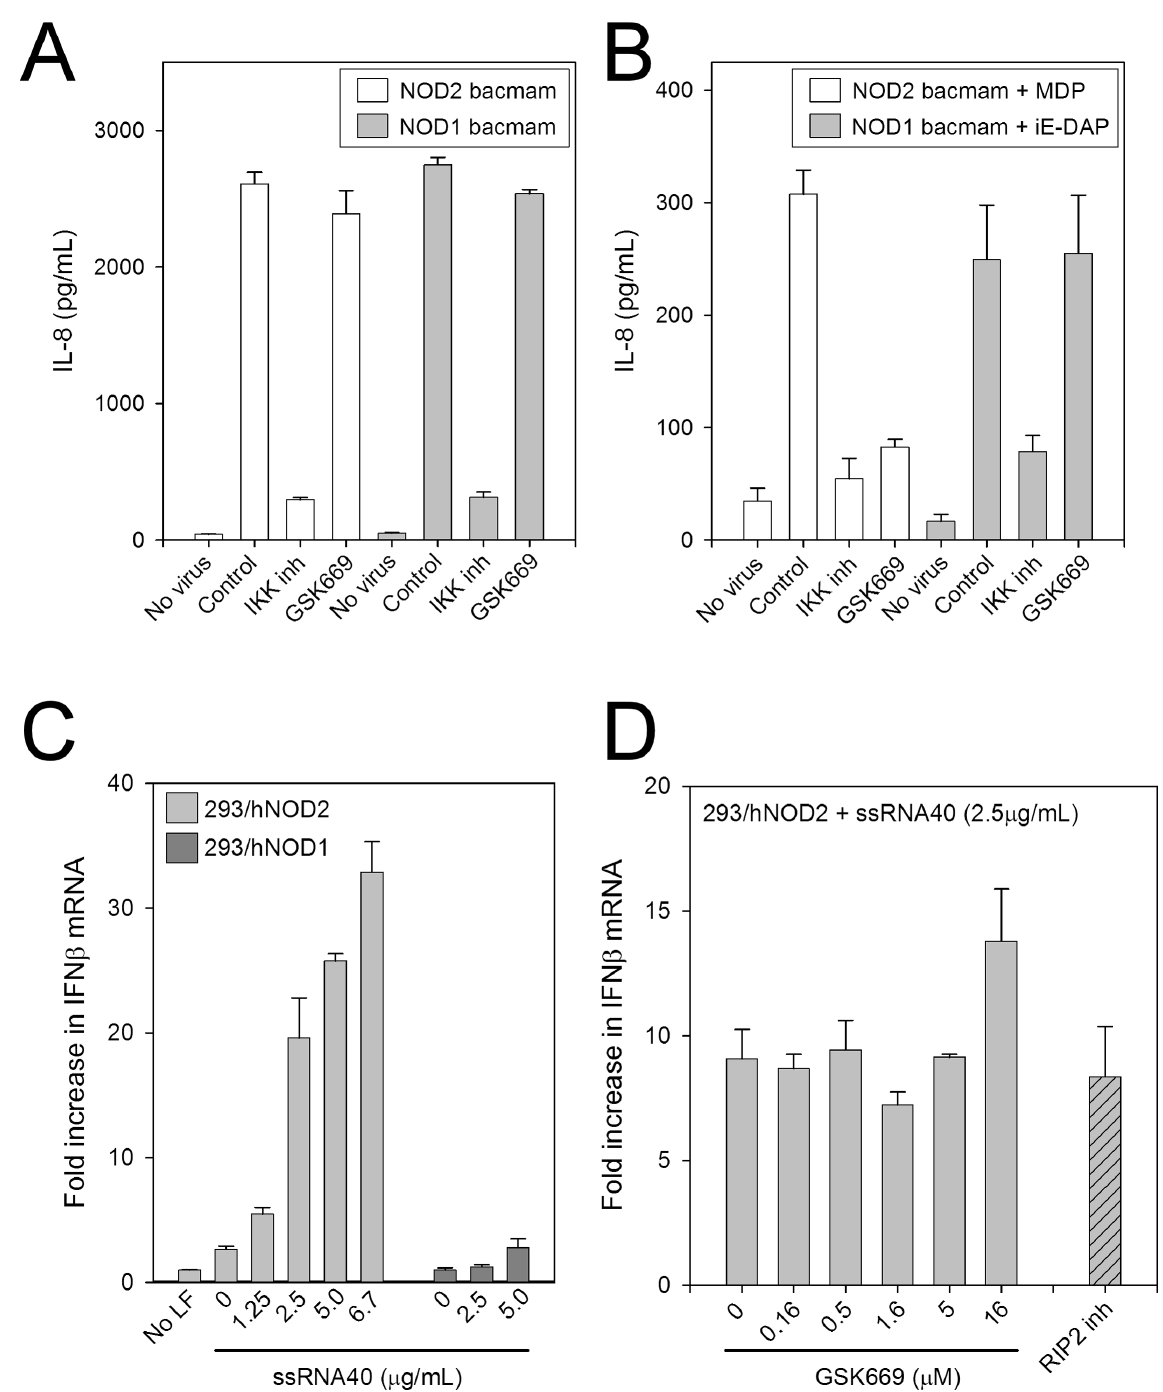
Figure 6. The activity of GSK669 is specific for inhibition of MDP-stimulated NOD2 responses. (A and B) Over-expression of NOD2 by viral transduction in HEK293T cells induces secretion of IL-8. Cells were infected (MOI=50) with NOD1 or NOD2 bacmam virus alone for either 24 hours (A) or for 6 hours followed by removal of virus and stimulation with iE-DAP (300 ng/mL) or MDP (30 ng/mL) for an additional 24 hours (B). GSK669 (5 m M) failed to block IL-8 secretion induced by NOD1/2 virus alone but selectively blocked the MDP response in NOD2 transduced cells. The IKK inhibitor (0.5 m M) suppressed IL-8 release under all conditions. Data in (A and B) are the mean 6 SD and are representative of two experiments. (C and D) Liposome-mediated transfection of ssRNA dose-dependently induces IFN b gene expression in 293/hNOD2 but not 293/hNOD1 stable cells and the response was unaffected by GSK669 (0.16–16 m M) and a RIP2 inhibitor (0.1 m M). Cells were pre-incubated with compound for 30 minutes prior to transfection with ssRNA. IFN b mRNA levels were measured after 6 hours by real-time RT-PCR. Data are presented as fold increase over mock transfected cells (mean 6 SD) and are representative of two independent experiments.